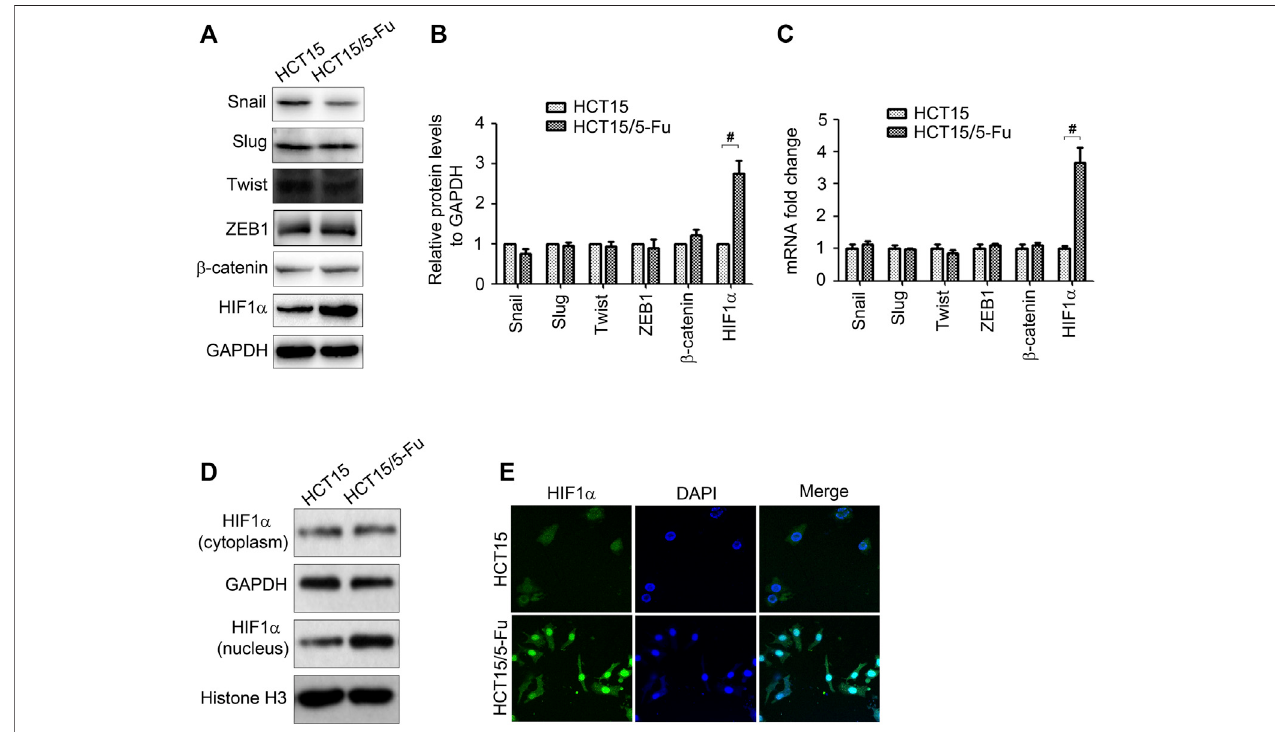
FIGURE3| HIF1 α isup-regulatedin5-Fu resistantCRC cells. (A – C) The protein and mRNA expression ofSnail, Slug,Twist, ZEB1, β -catenin and HIF1 α inHCT15 and HCT15/5-Fu cells were examined by WB and RT-PCR, respectively. (D) The HIF1 α expression in cytoplasm and nucleus in HCT15 and HCT15/5-Fu cells were examined by WB. (E) The cellar localization ofHIF1 α in HCT15 and HCT15/5-Fu cells was analyzed byIF staining. Nuclei were visualized with DAPI staining. #: p < 0.01.